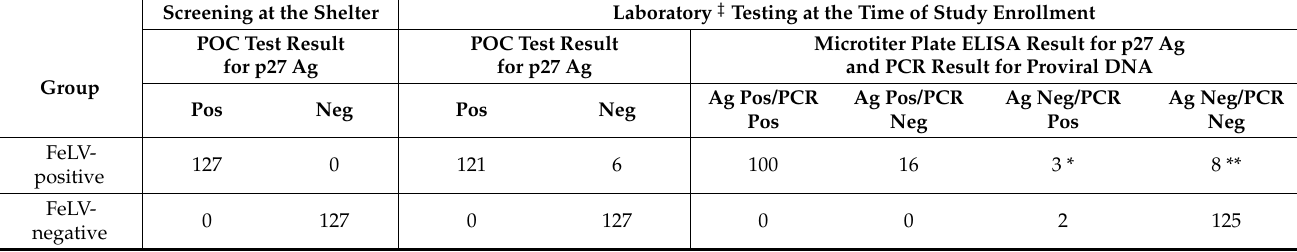
Table 1. Feline leukemia virus (FeLV) p27 antigen (Ag) and proviral DNA results for the enrolled population. Screening with the point-of-care (POC) test at the shelter occurred within the two weeks prior to study enrollment. The POC test was repeated at the laboratory with the sample obtained at the time of enrollment (time